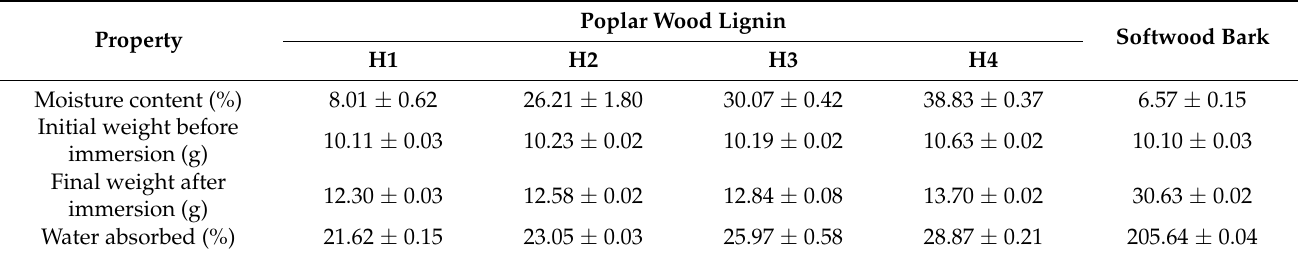
Table 4. Scenario 1: mass of pellets before and after being immersed in water for 2 min as well as the percentage of water absorbed.